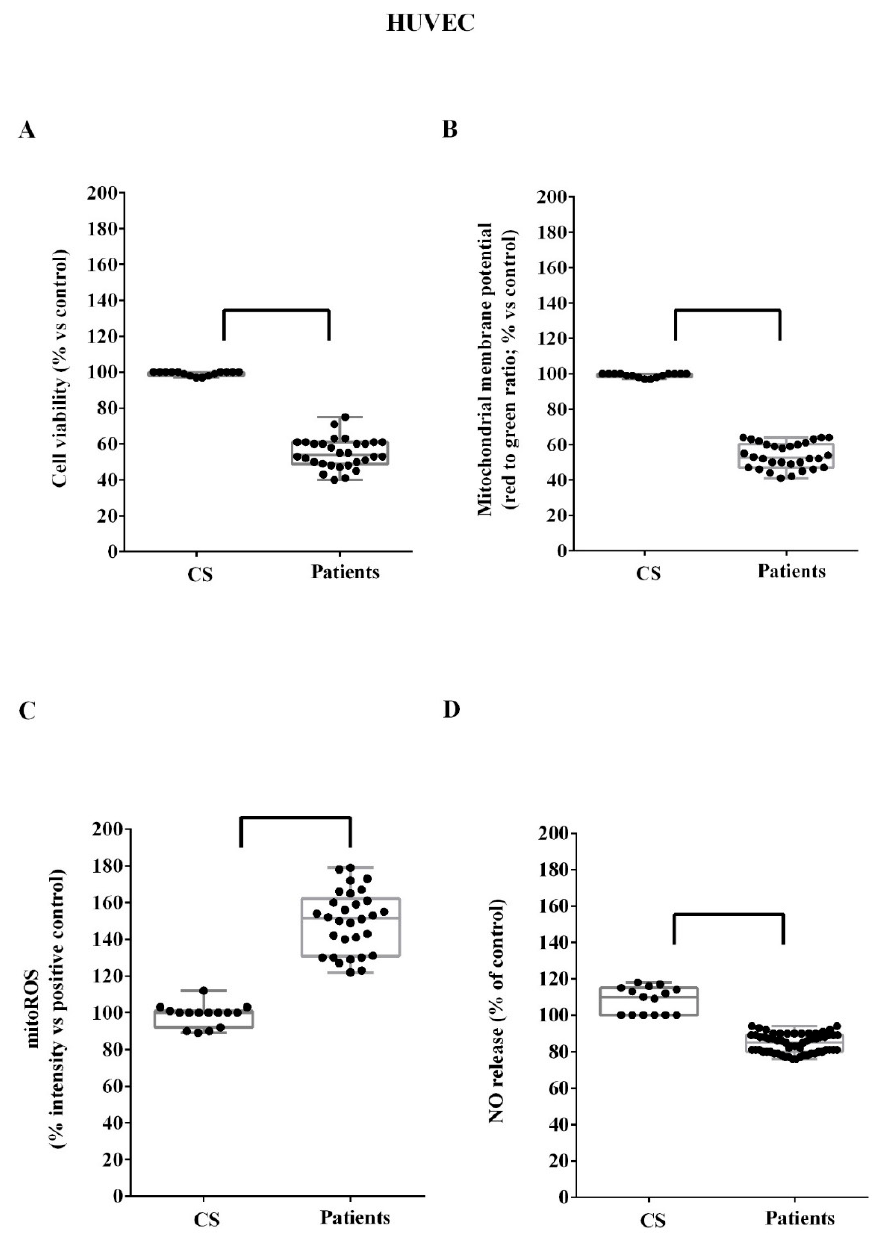
Figure 3. Effects of ALS patient plasma on cell viability ( A ), mitochondrial membrane potential ( B ), mitochondrial reactive oxygen species (mitoROS; ( C )), and NO release ( D ) in HUVEC. CS: control samples. NO. nitric oxide. Square brackets indicate significance between groups as p < 0.05.